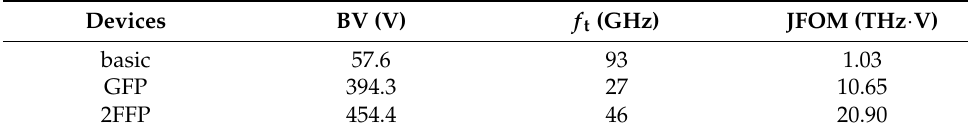
Table 2. BV, f t , and JFOM calculated summary for basic, GFP, and 2FFP structures. Devices